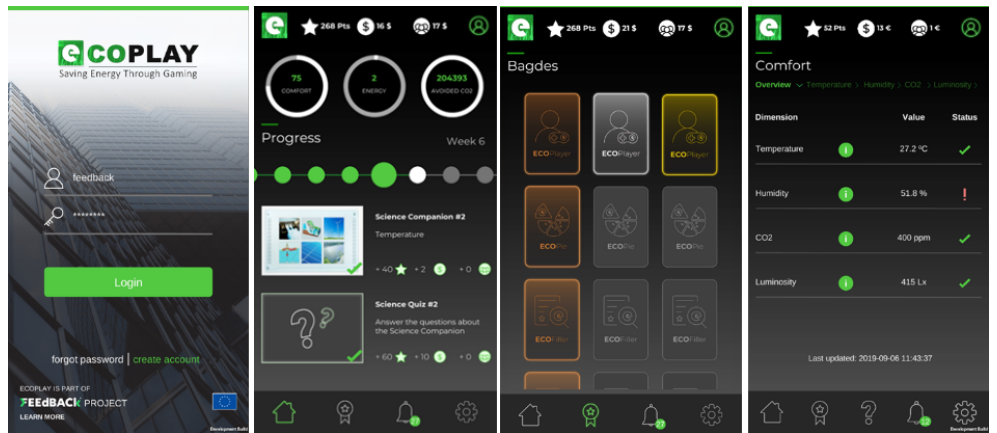
Figure 12. Screens from the mobile